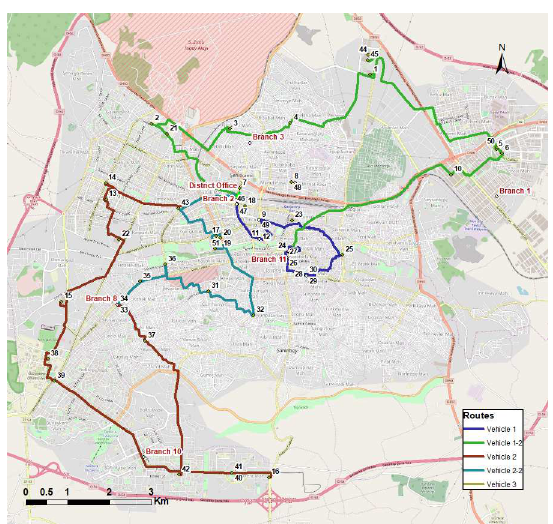
Figure 10. Solution of